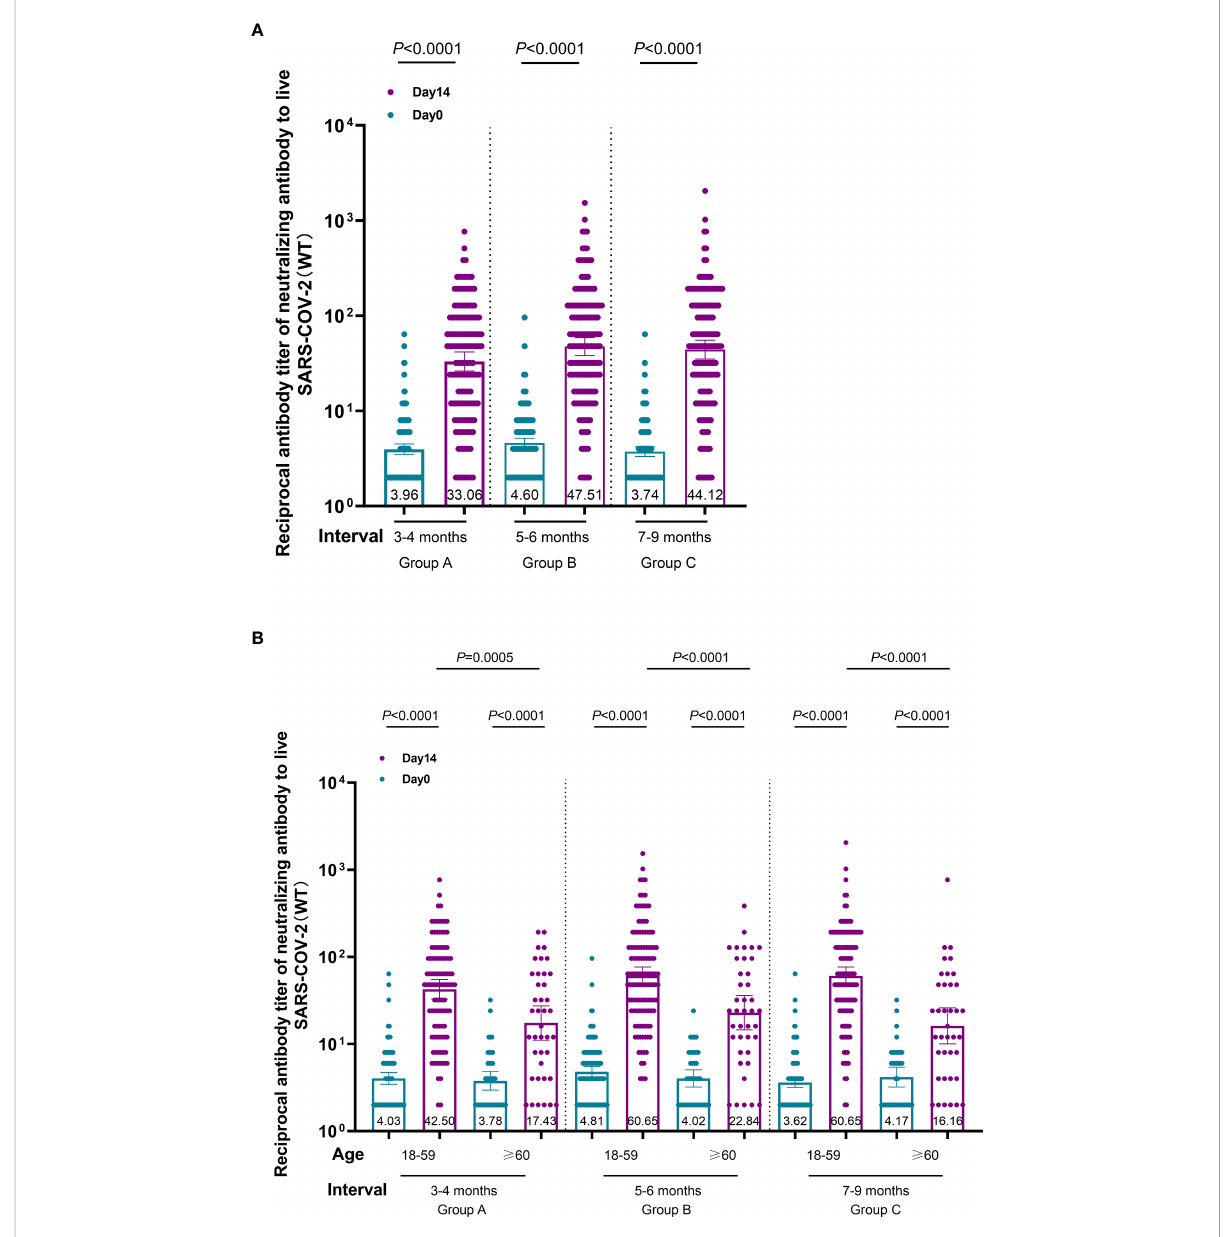
FIGURE 3 Immunogenicity of the booster vaccine (ZF2001) in participants of each group on Day 0 and Day 14. (A) Titers of the different prime-boost time interval groups measured by infectious SARS-CoV-2 neutralizing assay. Circles show the individual neutralization titers. Bars represent the geometric mean titers (GMT) of neutralization antibody. Error bars refer to the 95% CI. Negative in neutralization antibody detection is represented as GMT = 2. (B) Titers of the different time interval groups and age subgroups measured by infectious SARS-CoV-2 neutralizing assay. The GMTs of participants aged 18 – 59 years and ≥ 60 years were compared among the three groups on Day-14 post-vaccination. Circles show the individual GMTs. Error bars refer to the 95%